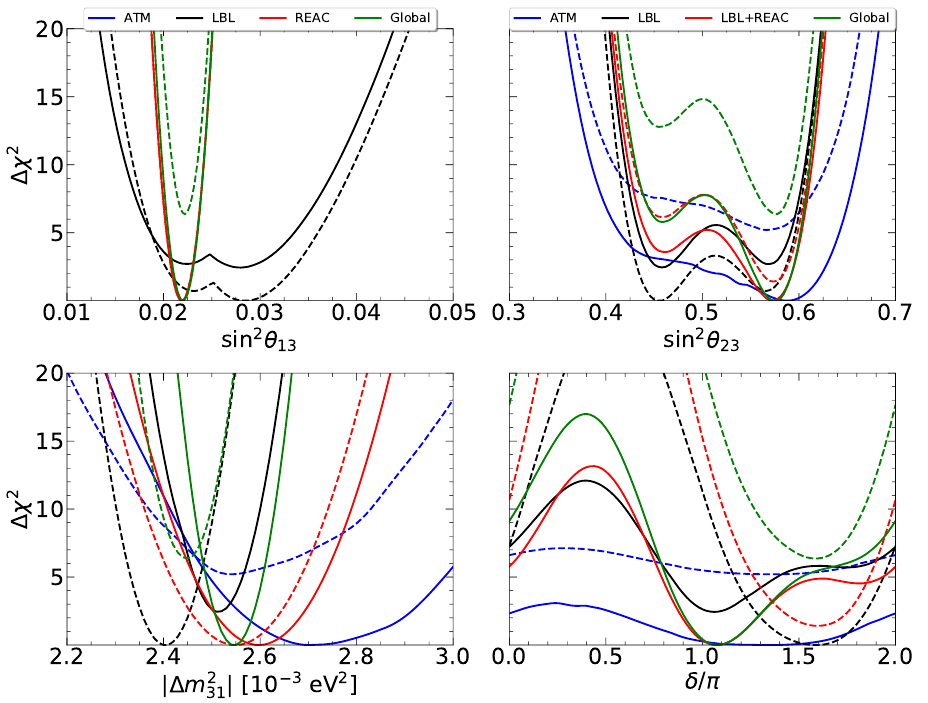
Figure 6 . ∆ χ 2 profiles obtained from the combination of all ATM data (blue), all LBL data (black) and global data (green). Red lines correspond to the analysis of all REAC data in the panels of the parameters measured by reactor experiments directly and to LBL+REAC data for the parameters where reactors enter only via correlations. The solid (dashed) lines correspond to NO (IO). The profiles are calculated with respect to the global minimum for each data sample, corresponding to normal ordering in all